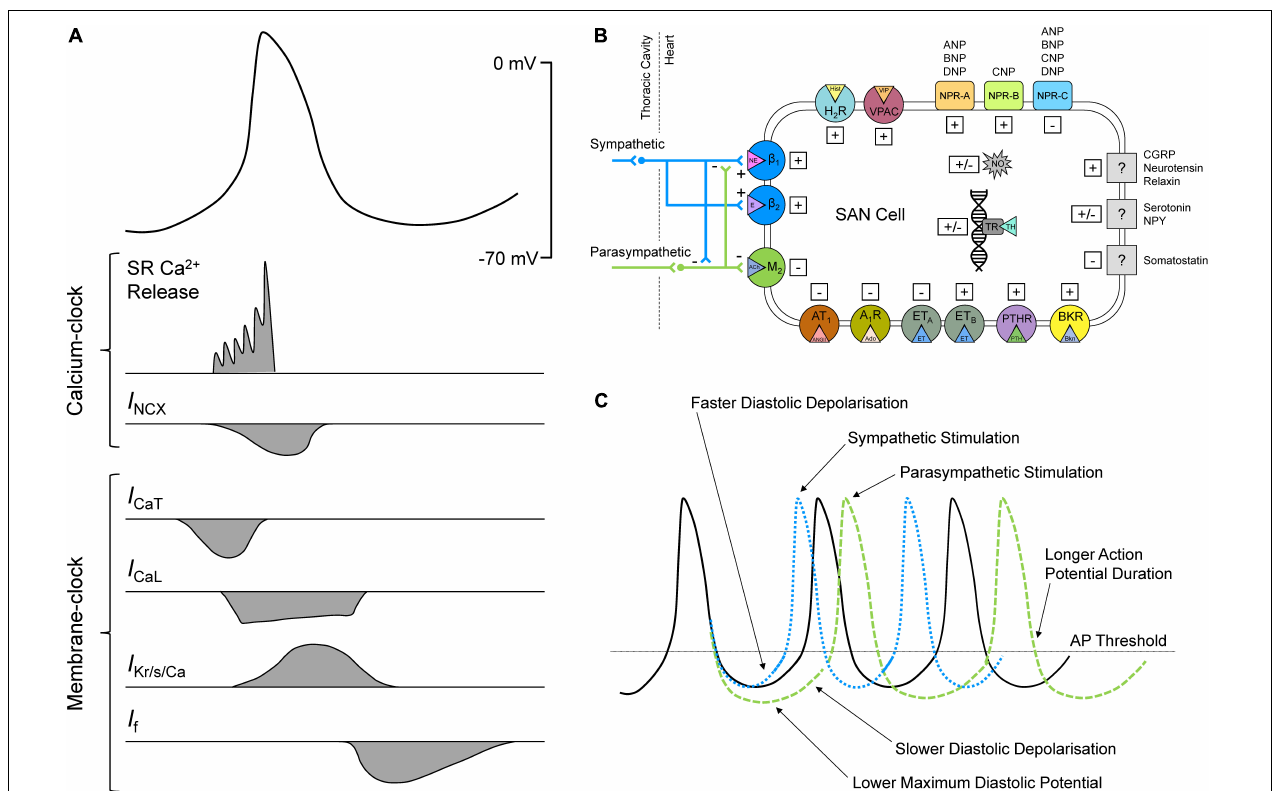
FIGURE 1 | Sinoatrial node (SAN) cell action potential (AP) and ionic fluxes responsible for automaticity (A) , neurotransmitters and neuropeptides, autocrine, paracrine, and endocrine factors, and other biologically active agents with known effects on SAN activity and heart rate (B) , effect of sympathetic and parasympathetic stimulation on the SAN AP (C) . A 1 R, adenosine receptor 1; ACh, acetylcholine; Ado, adenosine; ANGII, angiotensin II; ANP, atrial natriuretic peptide; AT 1 , angiotensin receptor 1; BNP, brain natriuretic peptide; Bkn, bradykinin; BKR, bradykinin receptor; Ca 2 + , calcium; CGRP, calcitonin gene-related peptide; CNP, C-type natriuretic peptide; DNP, Dendroaspis natriuretic peptide; E, epinephrine; ET, endothelin; ET A / B , endothelin receptor A/B; H 2 R, histamine H2 receptor; Hist, histamine; I CaL , long-lasting (L-type) Ca 2 + current; I CaT , transient (T-type) Ca 2 + current; I f , “funny” current; I Kr / s / Ca , rapid delayed rectifier / slow delayed rectifier / Ca 2 + -activated K + currents; I NCX , Na + -Ca 2 + exchanger current; M2, muscarinic receptor 2; NE, norepinephrine; NO, nitric oxide; NPR,